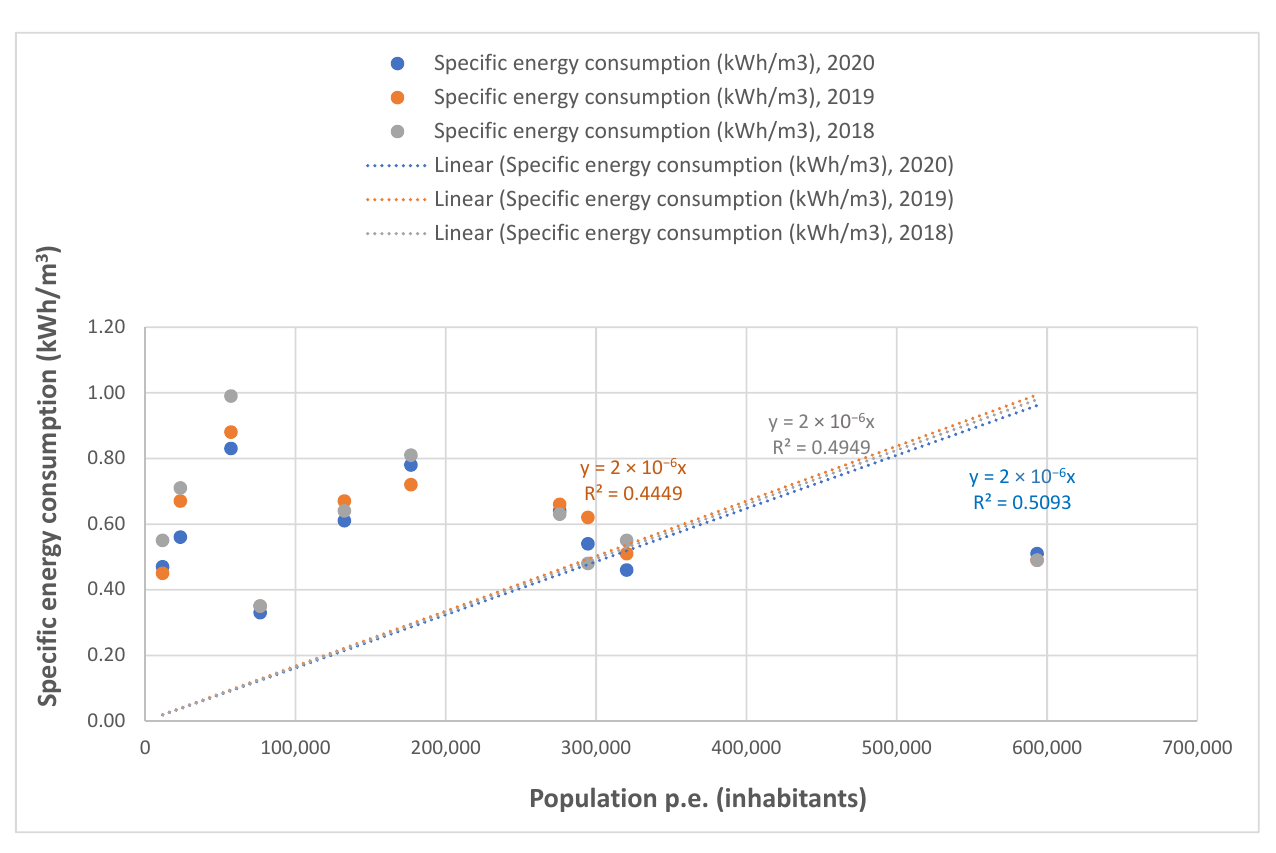
Figure 3. Linear (specific) energy consumption for the 11 Portuguese wastewater management companies.